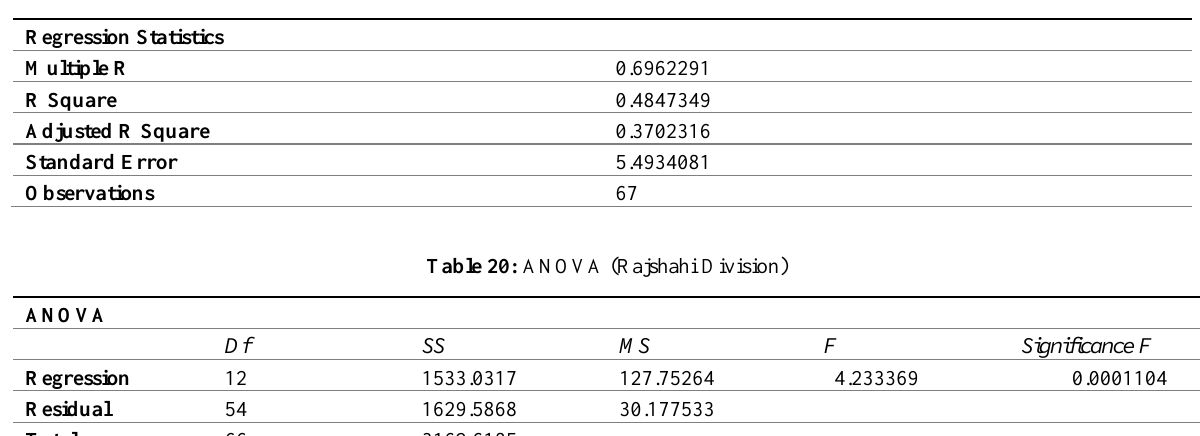
Table 19: Regression Statistics (Rajshahi Division)